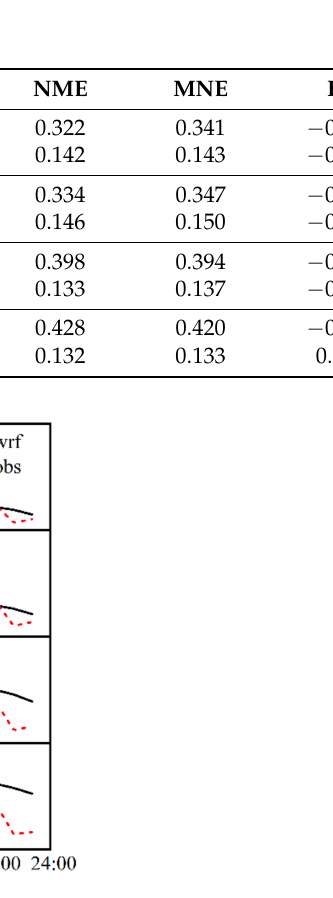
Figure 6. WRF simulated wind speed and observed wind speed at different heights (9 m, 18 m, 36 m, 54 m from top to